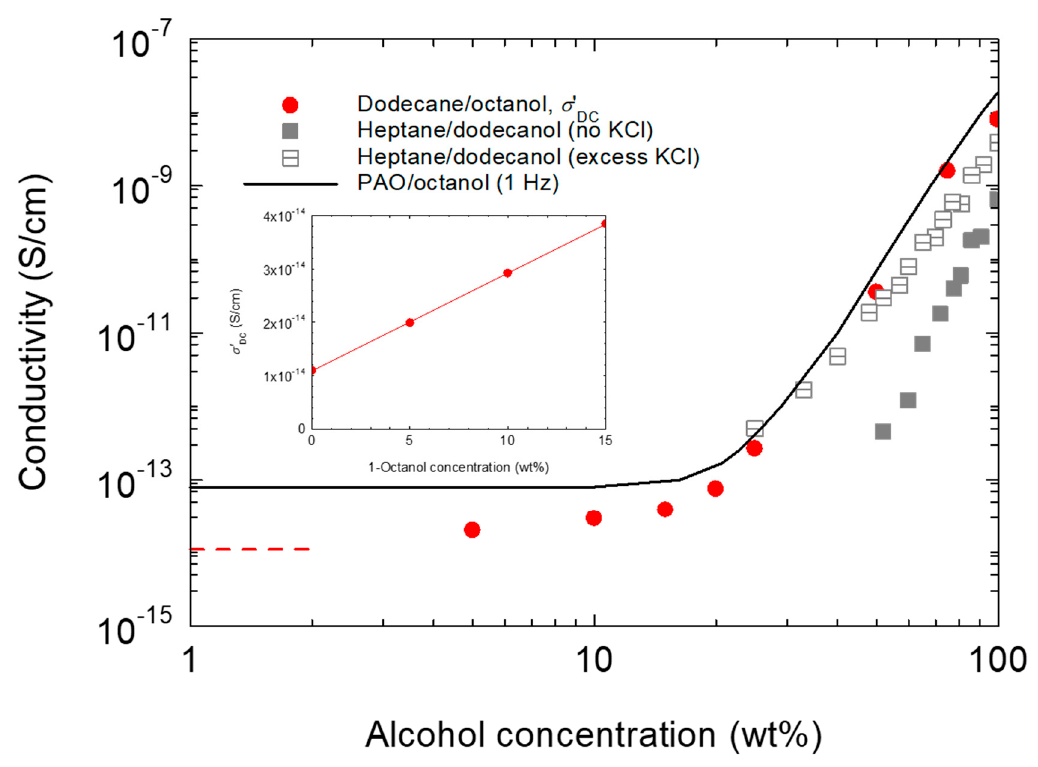
Figure 6. Electrical conductivity of dodecane/octanol mixtures (filled red circles). The red dashed line is the value for n -dodecane. The solid line is for poly( α -olefin) (PAO)/1-octanol mixtures from Bombard and Dukhin [32], which were measured at 1 Hz. The open and filled squares are from Gourdin–Bertin and Chassagne [35] for the n -heptane/1-dodecanol system in the presence and absence of excess solid potassium chloride, respectively. The inset shows low concentration data for the dodecane/octanol system on linear axes.